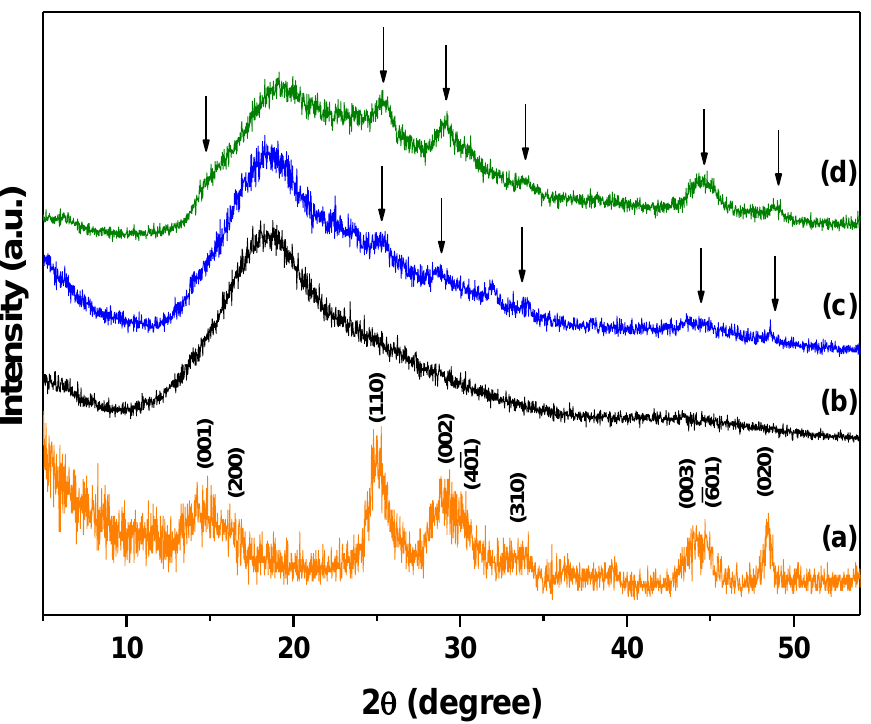
Figure 3. XRD patterns of ( a ) TiO 2 (B) (prepared by heating the as-synthesized titanium oxide at 500 °C for 2 h), ( b ) sPSU membrane, sPSU/2% TiO 2 (B) ( c ) and sPSU/10% TiO 2 (B) ( d ) composite membranes.